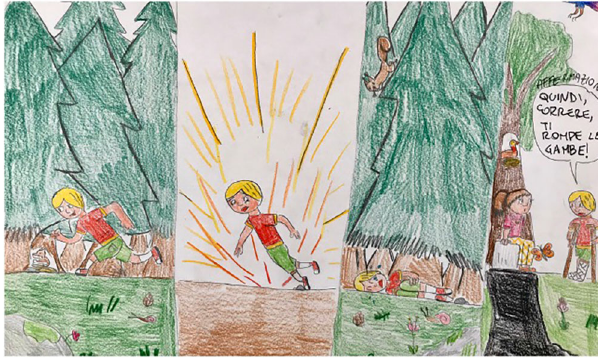
Figure 5. Drawing from a child explaining the Key Concept of “ Personal Experience ”